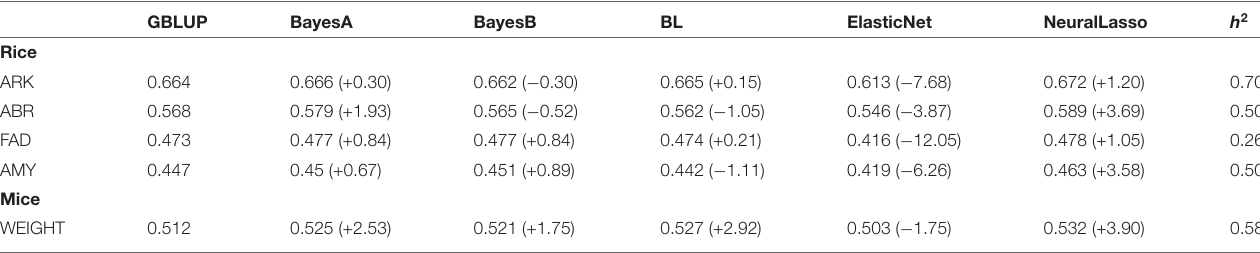
TABLE 1 | Mean prediction accuracy based on 50 CV replicates using different approaches for the traits with rice (ARK, ABR, FAD, AMY) and mice (WEIGHT) data sets are shown along with the corresponding heritability ( h 2 ) estimate for the trait. GBLUP BayesA BayesB BL ElasticNet NeuralLasso h 2